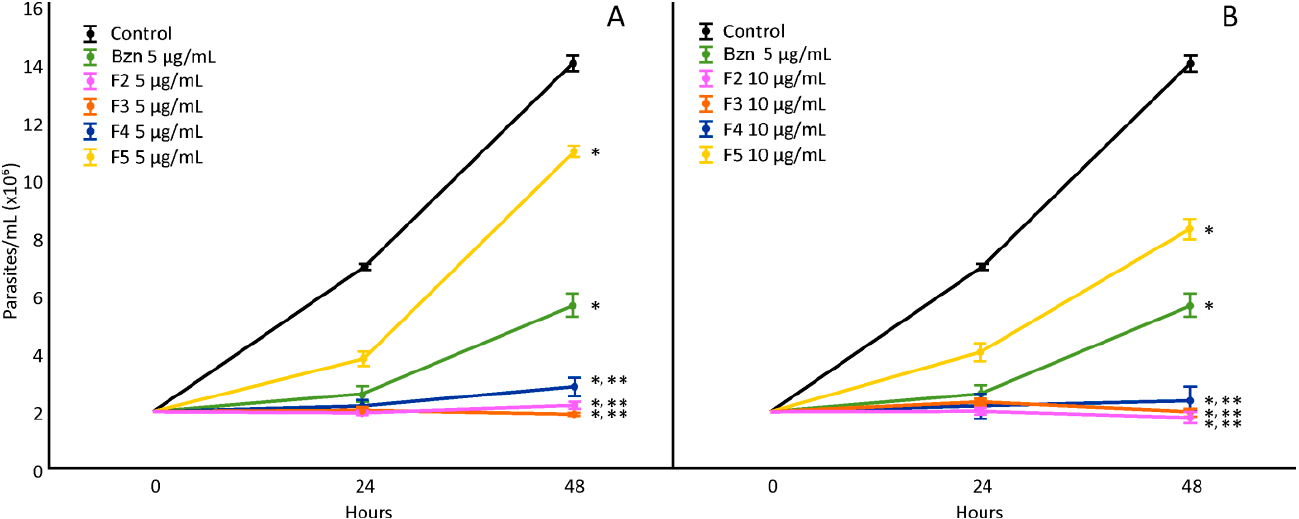
Figure 2. Effect of H. hybrid BARE fractions on T. cruzi epimastigotes at concentrations of 5 µg/mL ( A ) and 10 µg/mL ( B ). *: Significant difference from negative control; **: significant difference from positive control. p < 0.05.